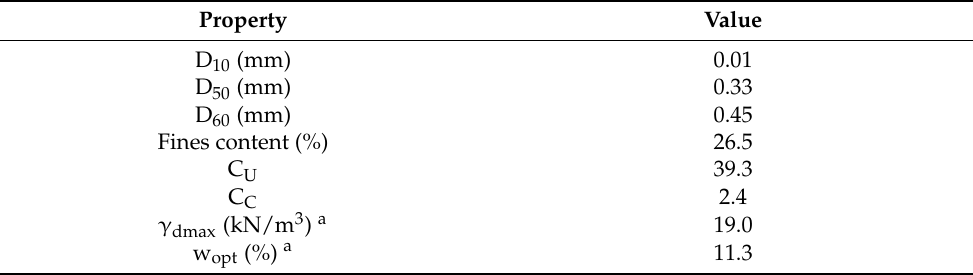
Table 2. Physical properties of the recycled C&D material.